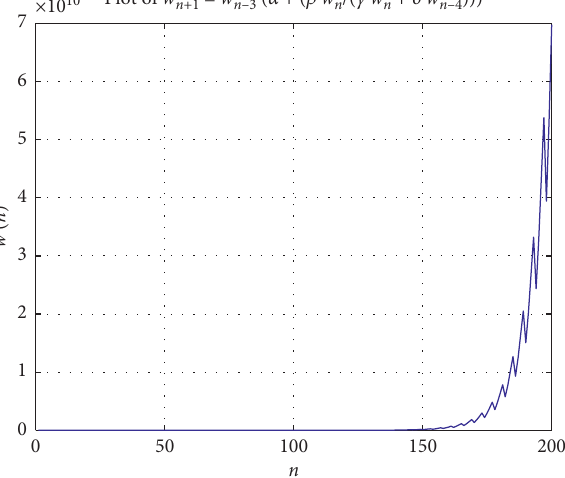
Figure 2: Unbounded solution of equation